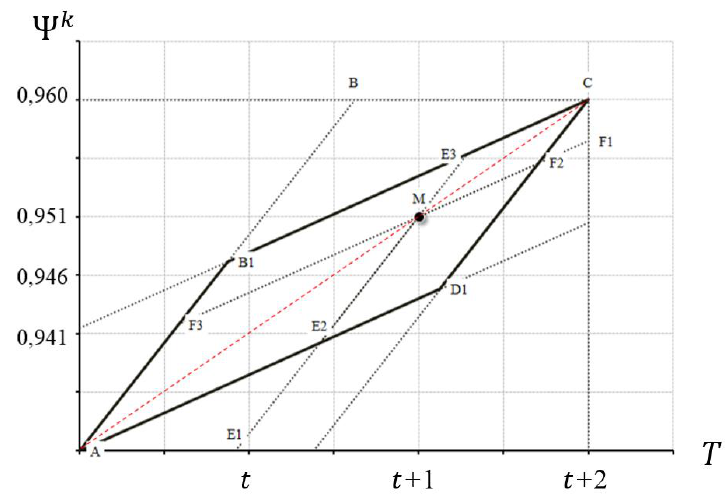
Figure 4. Calculated example. Operated condition of the